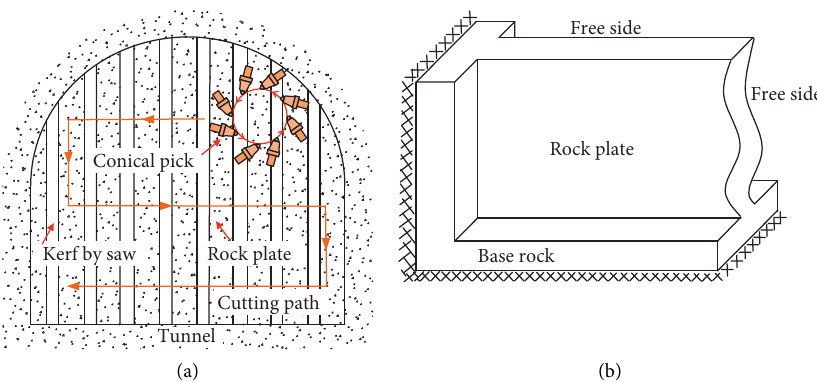
Figure 1: Rock cutting method based on multiple free surfaces formation. (a) Roadway tunneling sketch based on new cutting method. (b) Rock plate cutting with two sides fixed and two sides free.